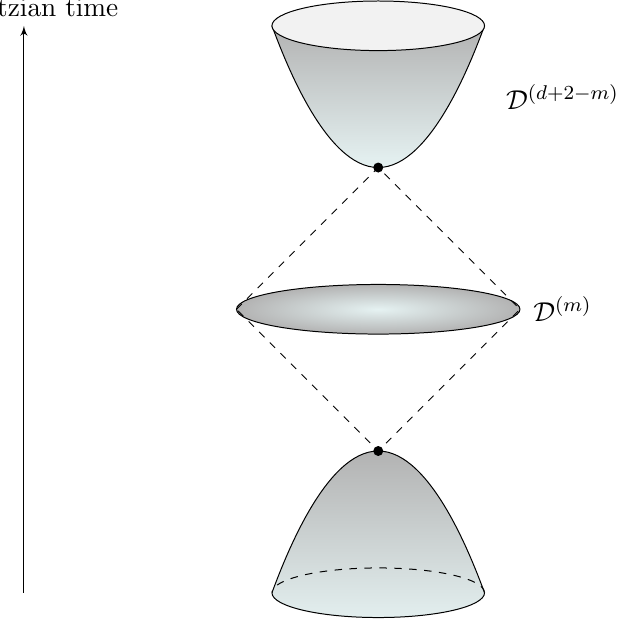
Figure 2 . A codimension- m spherical defect and its dual